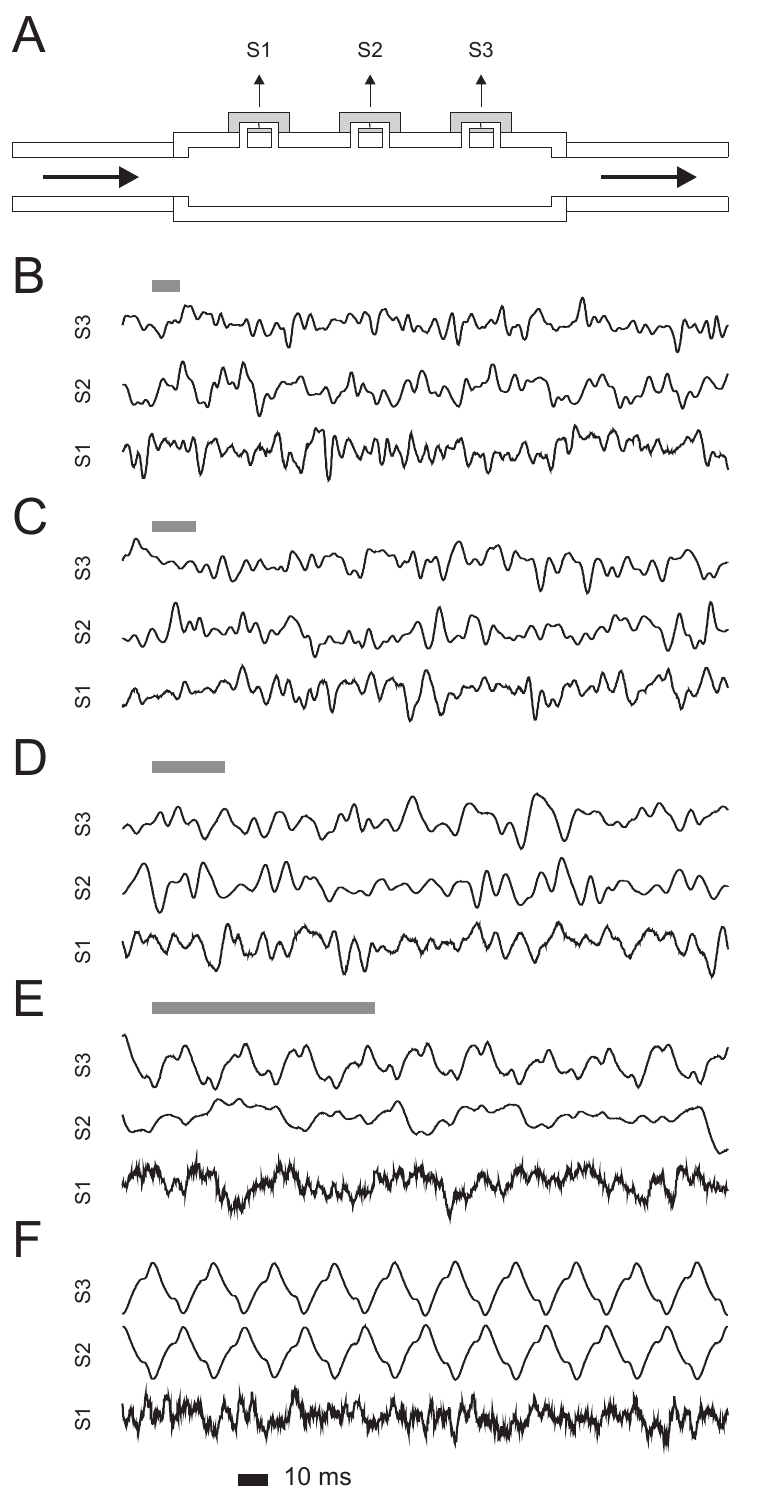
Figure 7. Setup and output signals of the micro-machined sensors in the tap water metering application. ( A ) Measuring tube featuring three MEMS sensors (S1, S2 and S3) mounted on adapter plates (see Figure 2). ( B – F ) The output signals of the three sensors obtained while applying flow rates of 4066 L/h ( B ), 2550 L/h ( C ), 1536 L/h ( D ), 500 L/h ( E ), and 50 L/h ( F ). Gray bars indicate expected delay of